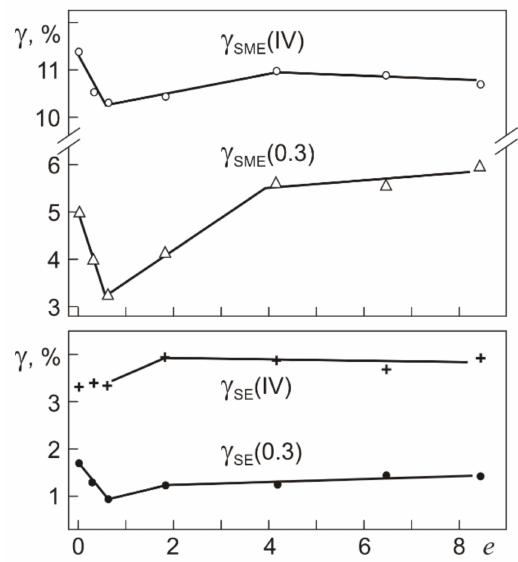
Figure 12. Reversible inelastic strains γ SE (0.3) and γ SME (0.3) at τ 0.3 , and γ SE (IV) and γ SME (IV) at τ 0.3 (IV) in Ti 49.8 Ni 50.2 in isothermal loading–loading cycles (295 K) with heating in unloaded states (500 K) as a function of the true strain e in warm abc